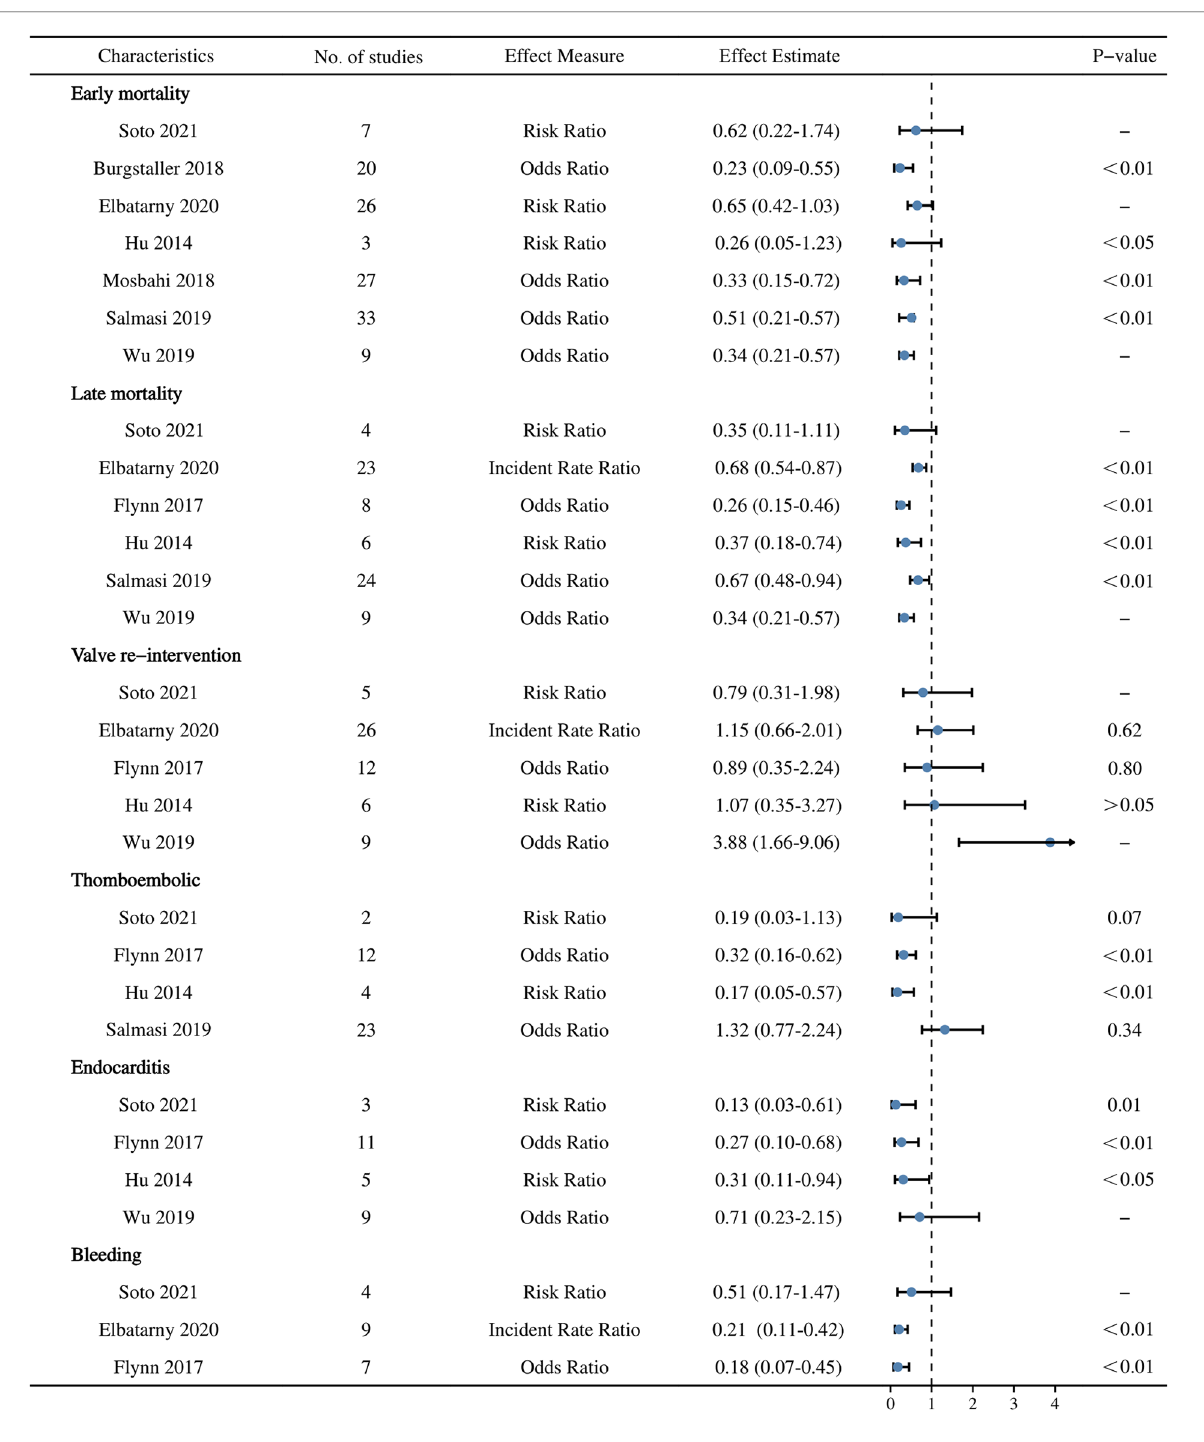
FIGURE 3 A summary of the 6 postoperative outcomes evaluated using Grading of Recommendations, Assessment, Development and